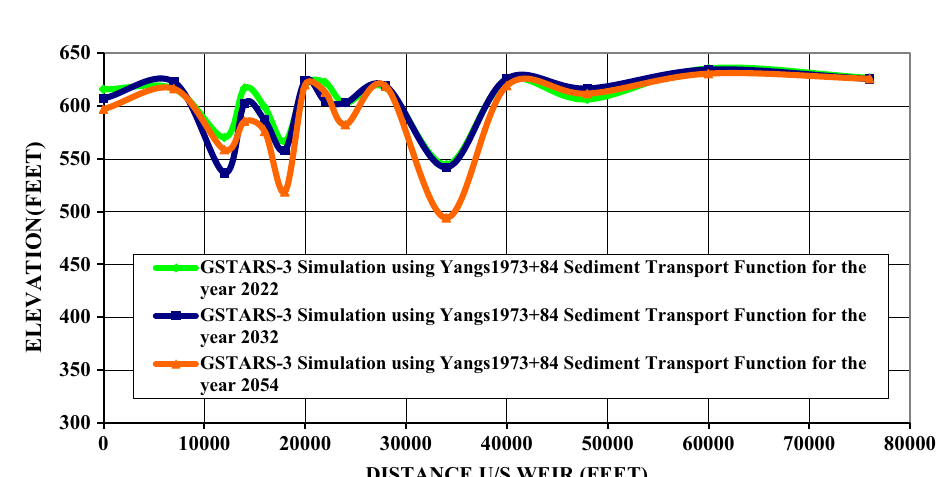
Fig. 8 Simulation results for